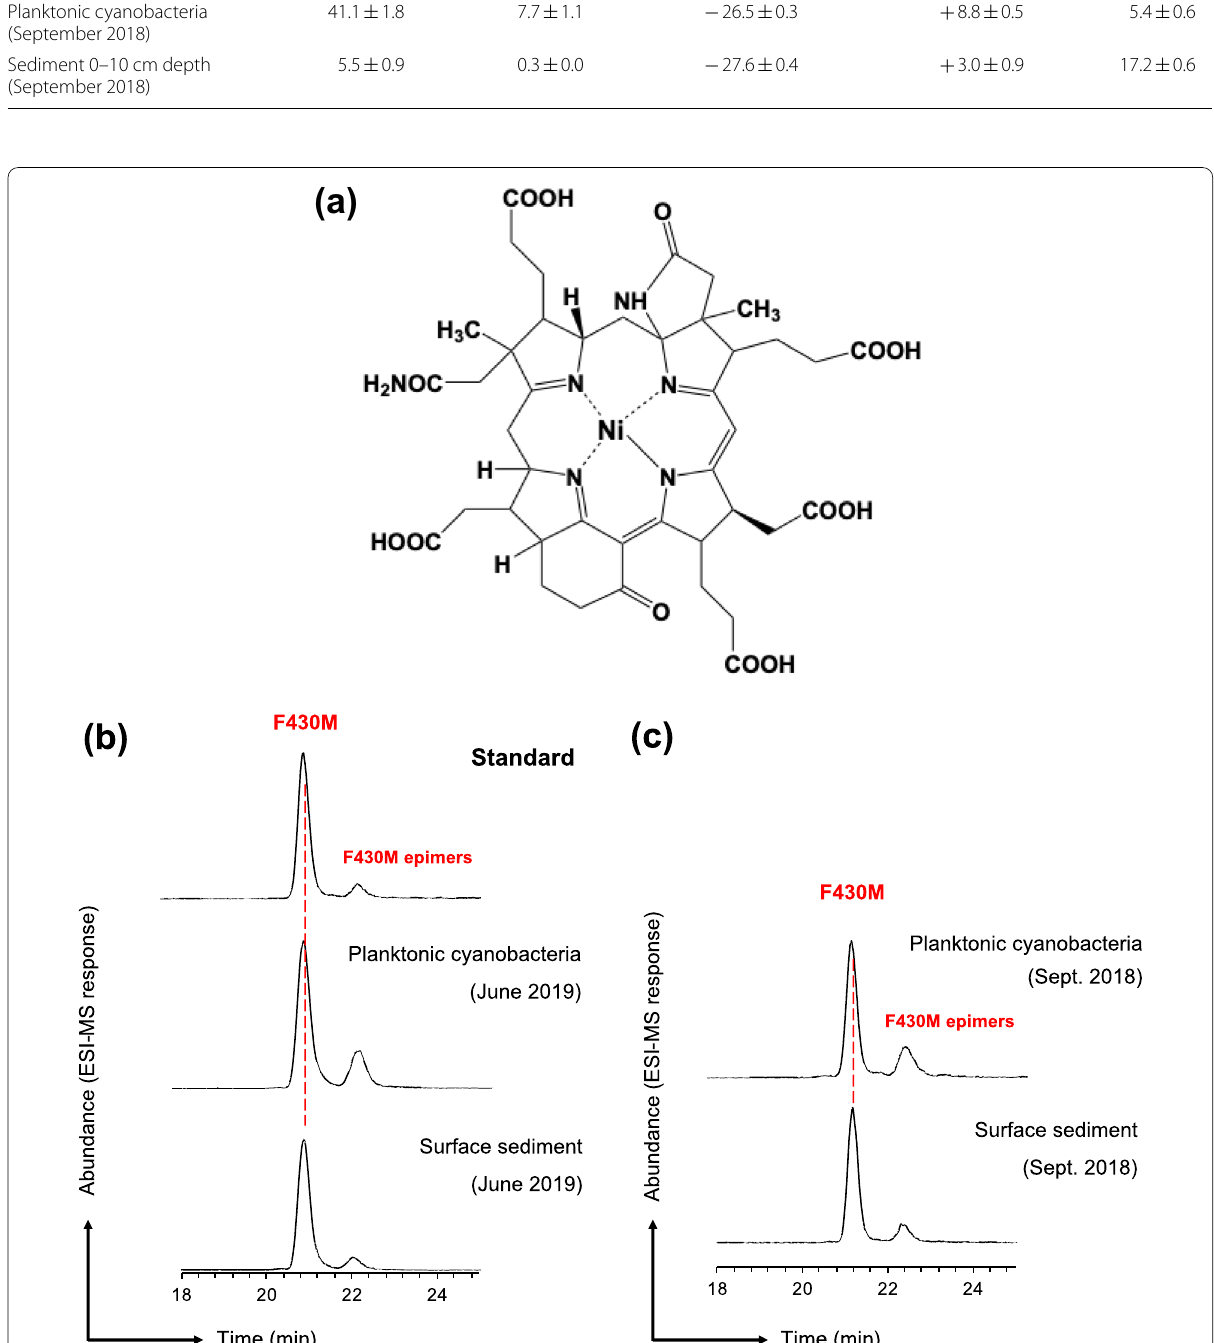
Fig. 4 a Structure of coenzyme factor 430 (F430), which has a chemical formula of C 42 H 51 N 6 NiO 13 . F430 is a hydrocorphinoid nickel complex that functions as an active site in MCR. The MCR–F430 complex catalyzes the last step of methanogenesis involving the reduction of methyl coenzyme M into CH 4 . b , c Chromatograms of the planktonic cyanobacterial samples analyzed via LC/ESI–MS/MS in MRM mode (Kaneko et al. 2014). The F430M product ion was set to m/z 844.3. The concentration of native F430 with assessment of the F430 epimer ratio enabled us to estimate the biomass of the in situ living methanogenic archaea (Kaneko et al.